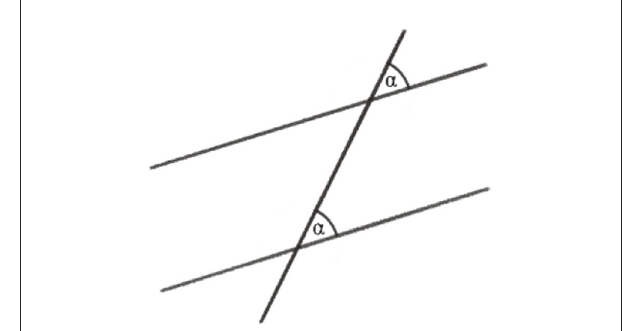
FIGURE1 Corresponding angles α .